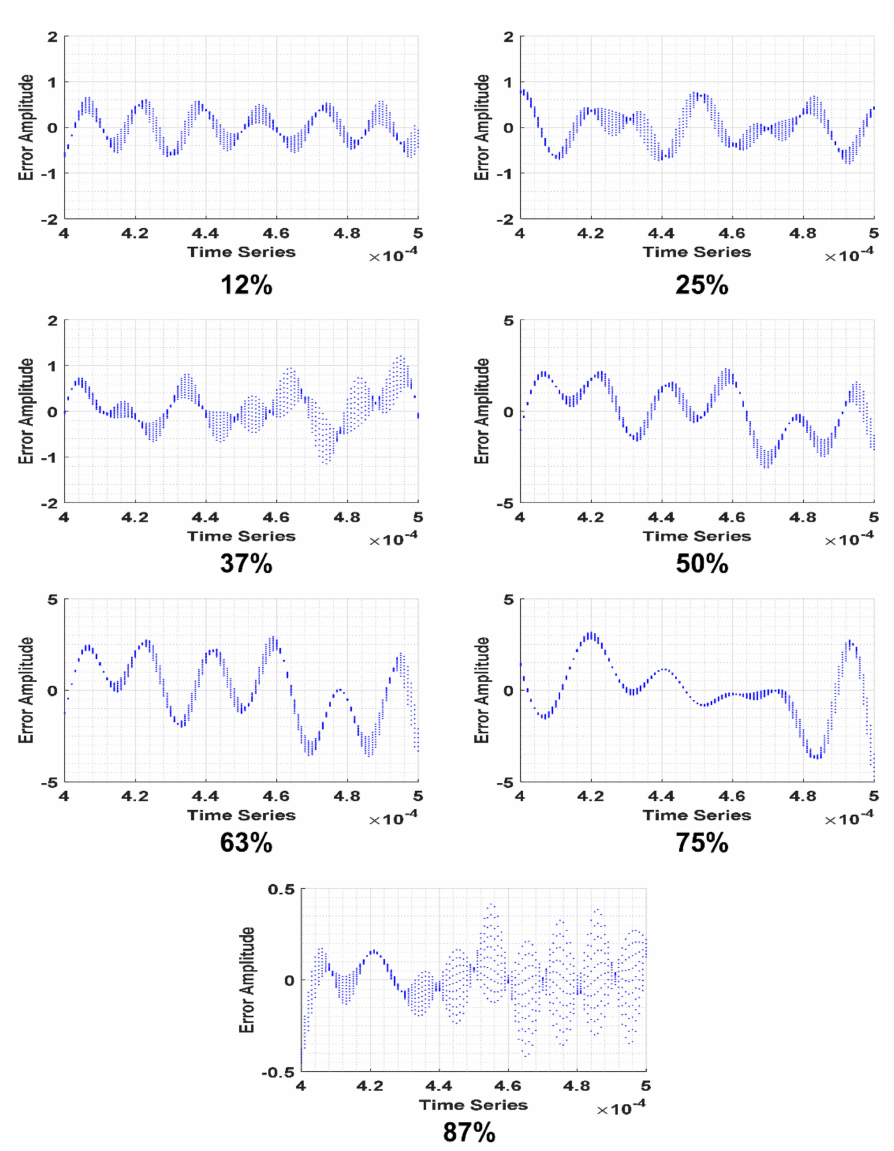
Figure 12. Residual error of the actual signal and model results for cracks at axis